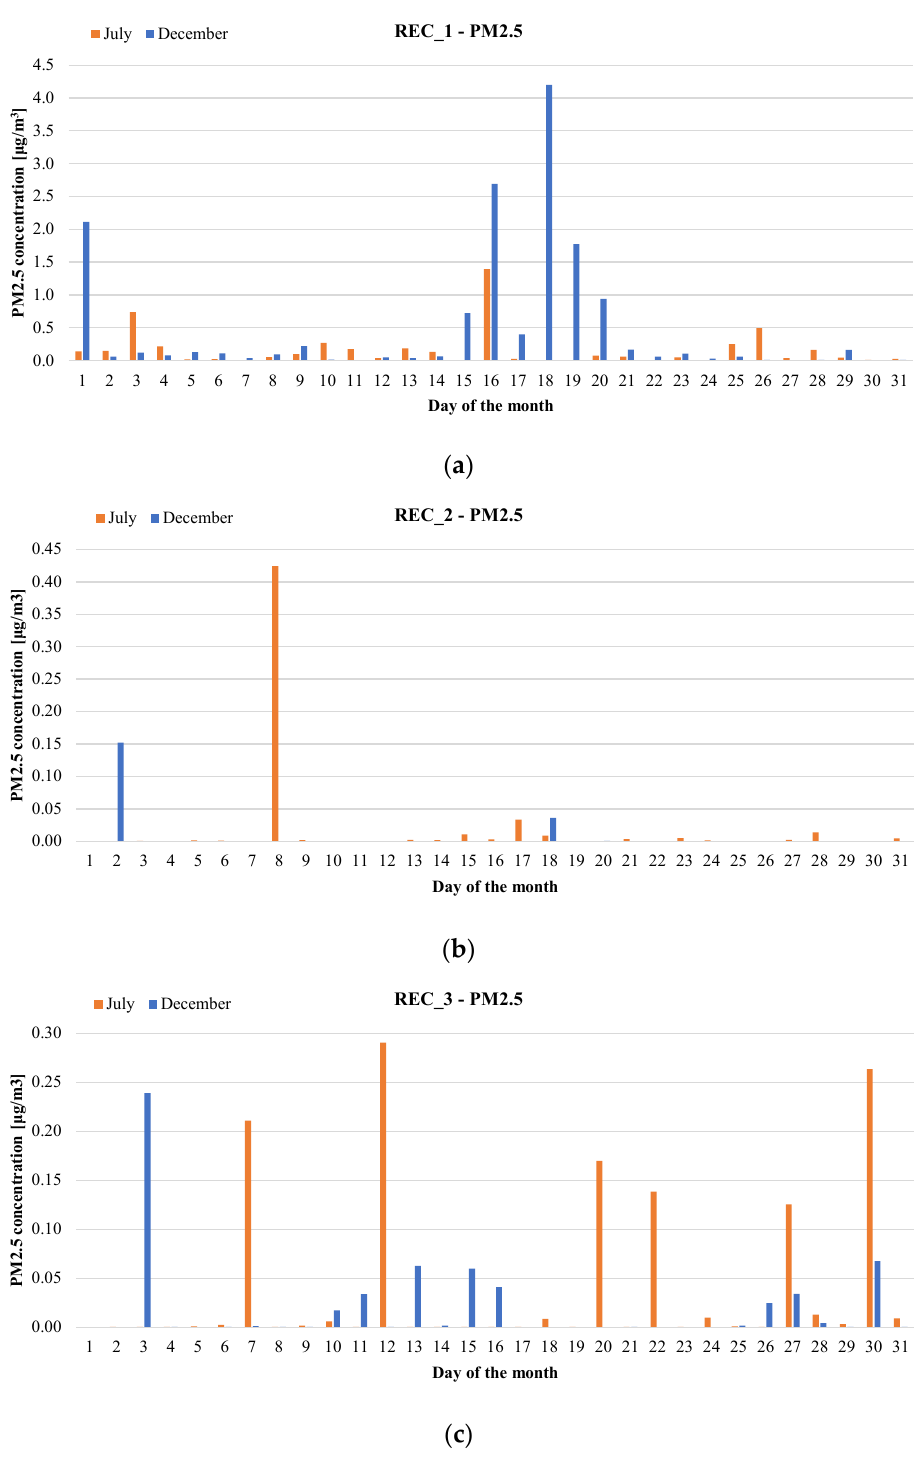
Figure 5. Average 24 h PM2.5 concentrations at ( a ) REC_1, ( b ) REC_2 and ( c ) REC_3 receptors. The monthly concentration characteristics of both NO x and PM2.5 were identical or nearly identical to those of carbon monoxide. Usually, maximum concentrations of CO occurred on the same days as maximum concentrations of nitrogen oxides and particulate matter. Small disproportions could be caused by differences in mass of emitted compounds or characteristics of their dispersion and transformations in the atmosphere. The smallest disproportions were visible for the REC_1 receptor located closest to the airport.